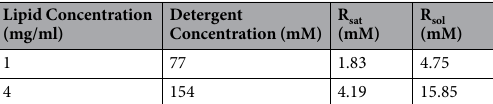
R sat < C Trit < R sol indicate the enlargement in the liposome diameter due to detergent incorporation within the membrane bilayers. Particle size distributions (PSD in terms of number distribution, %) corresponding to sol- ubilization with C Trit = 5 mM indicate two peaks at ~150 and 320 nm as compared to the peak size ~100 nm for